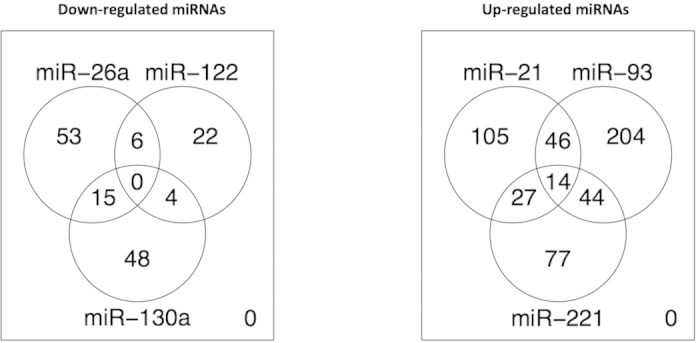
Differentially expressed targets shared by relevant miRNAs.Likely targets were determined by the GSEA pre-ranked function, comparing genes ranked by their negative correlation with the miRNA and the set of predicted targets by MiRanda. Only differentially expressed genes (absolute FC > 1.5 and FDR < 0.05) were considered.